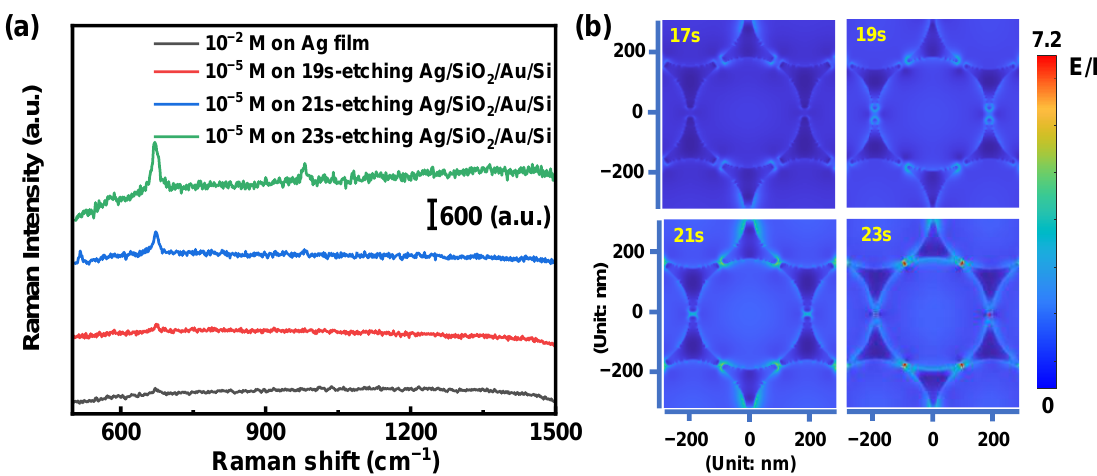
Figure 5. ( a ) Measured SERS spectra for the 10 − 5 M melamine on the Ag/SiO 2 /Au/Si substrates with different etching times of 19 s, 21 s, 23 s, and 10 − 2 M melamine on the Ag film substrate, respectively. ( b ) Electric field distributions on the nanostructured surface with different etching times. Scale bar: 100 nm.